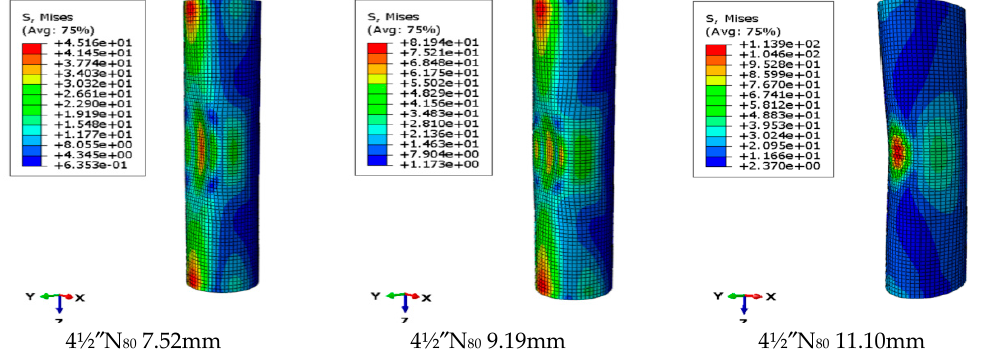
”N 80 -type casing. 2